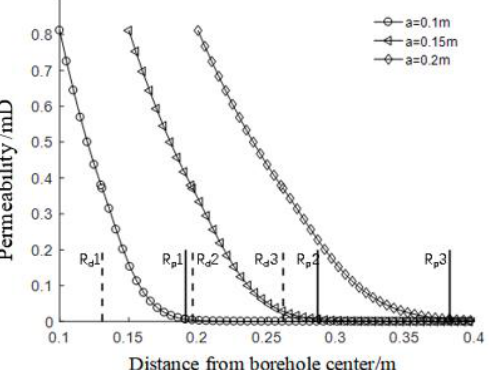
Figure 6. The change in coal rock permeability around the borehole under different borehole radius.